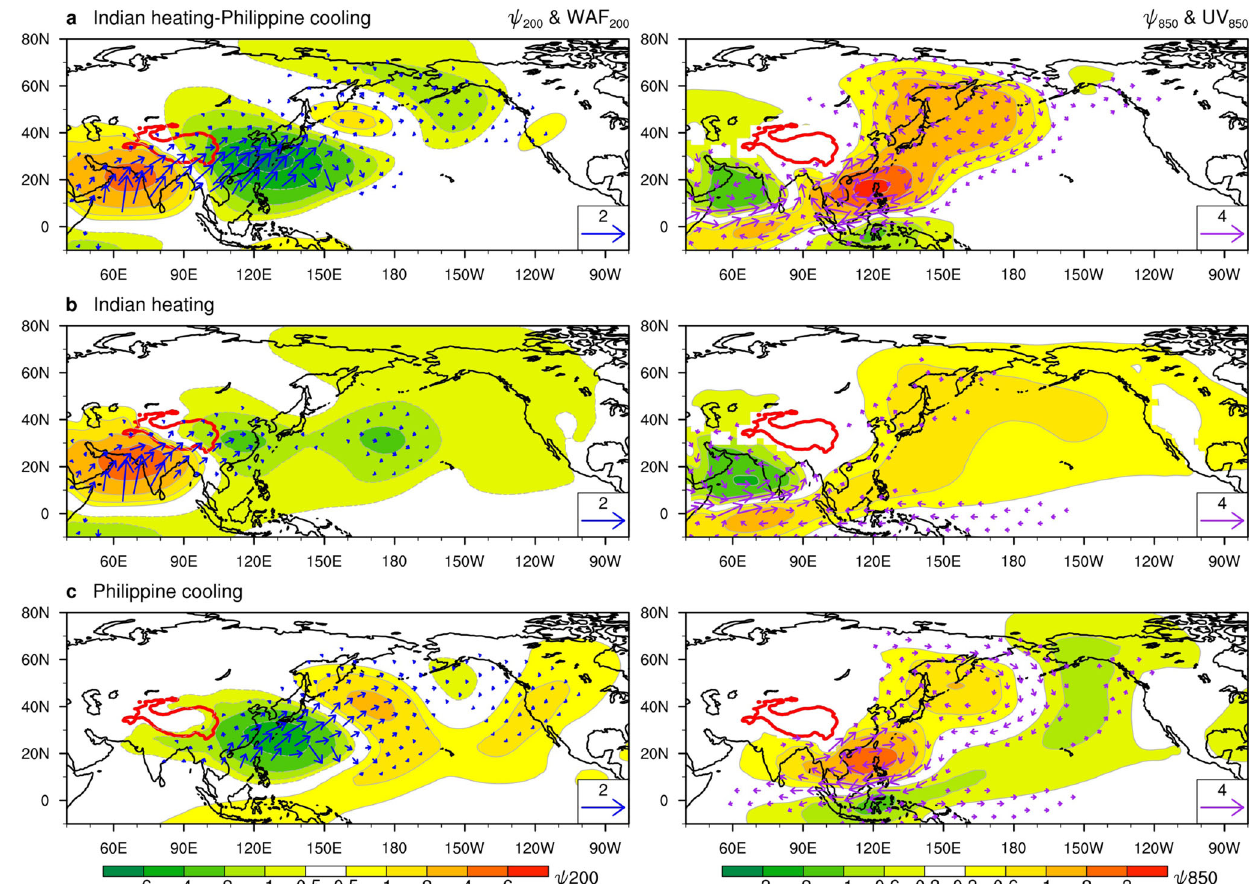
Fig. 3 Atmospheric response to the speci fi ed diabatic heating anomalies. a Dipole heating mimicking “ wet India - dry Philippine ” , b Indian diabatic heating only, and c Philippine diabatic cooling only. Left panels show 200 hPa stream function (shading, units: 10 6 m 2 s − 1 ) and wave activity fl ux (WAF; vector, units: m 2 s − 2 ). Right panels display 850 hPa stream function (shading, units: 10 6 m 2 s − 1 ) and winds (vector, units: m s − 1 ). The speci fi ed heating patterns and vertical structures are shown in Supplementary Fig. 1. The maximum (minimum) heating rate is 2 K day − 1 ( − 2 K day − 1 ). The damping time scale is 5 days. The response is on Day 10. The basic state is November mean fl